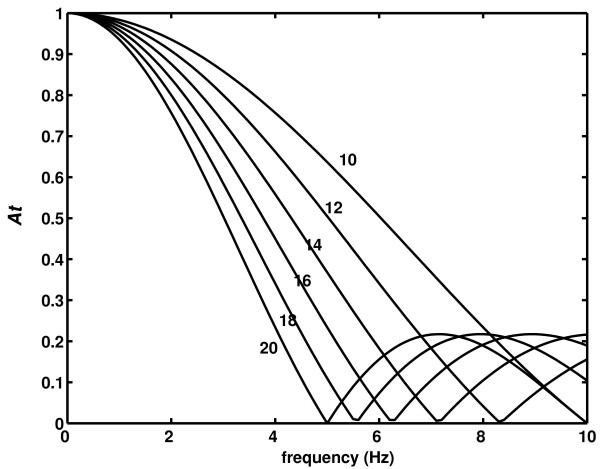
Low-pass filtering properties of a series of moving windows. At – amplitude attenuation; different lines correspond to different window lengths (Nw = 10,12,...,20 samples); signal sampled at fs = 100 samples/s.